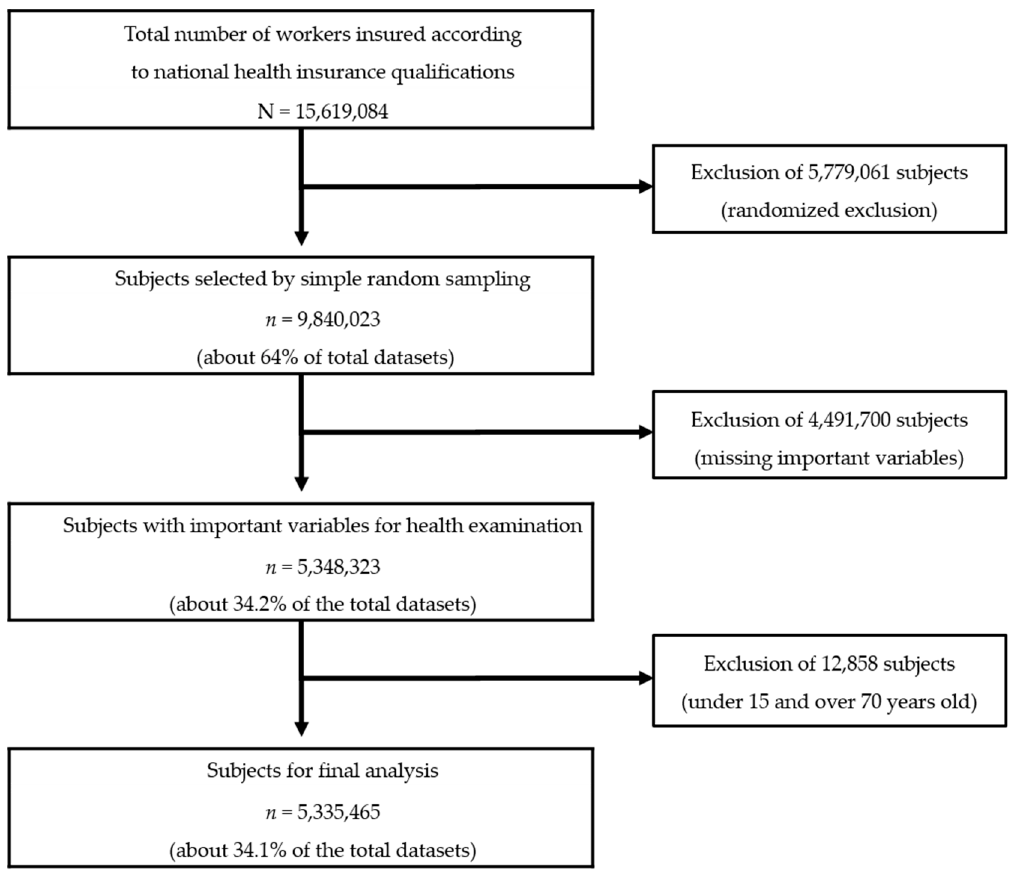
Figure 1. Flow diagram showing study sample and sampling method. N was the total number of the insured workers and n was the number of subjects selected according to the sampling process.